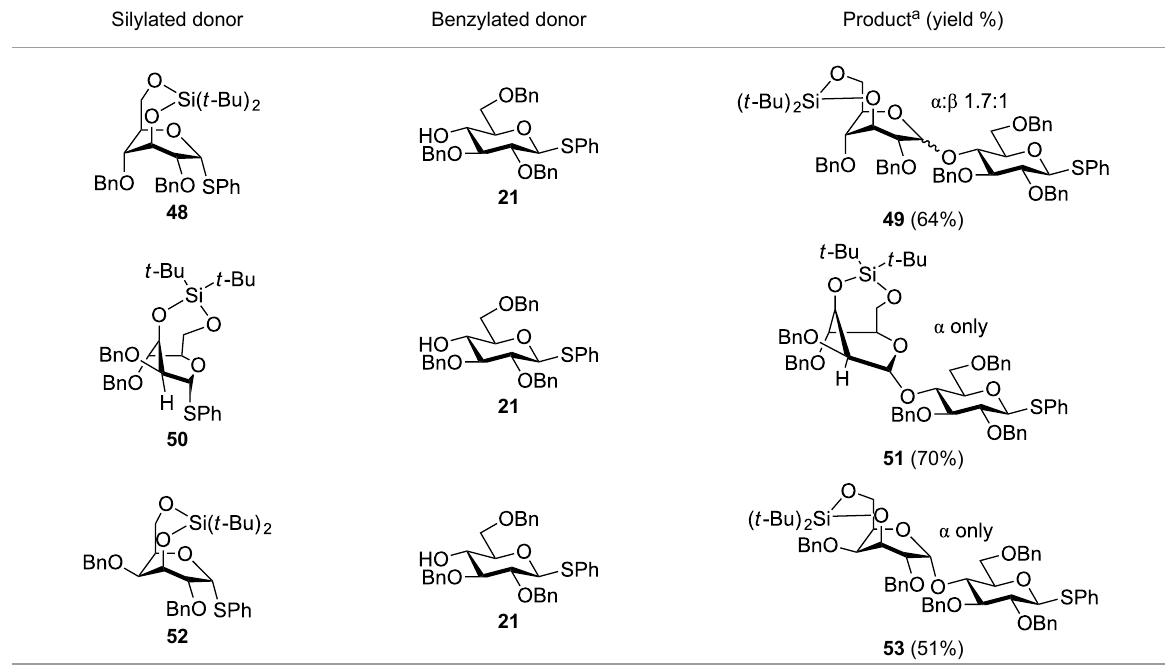
Table 2: Reactions of 3,6- O -silyl-tethered